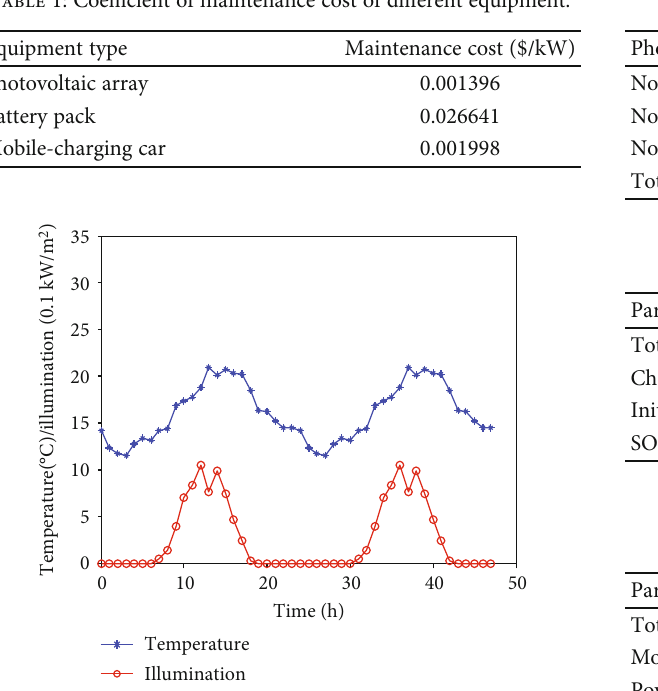
Figure 3: Distributed structure of players. Table 1: Coe ffi cient of maintenance cost of di ff erent equipment. Table 2: Photovoltaic array parameters.